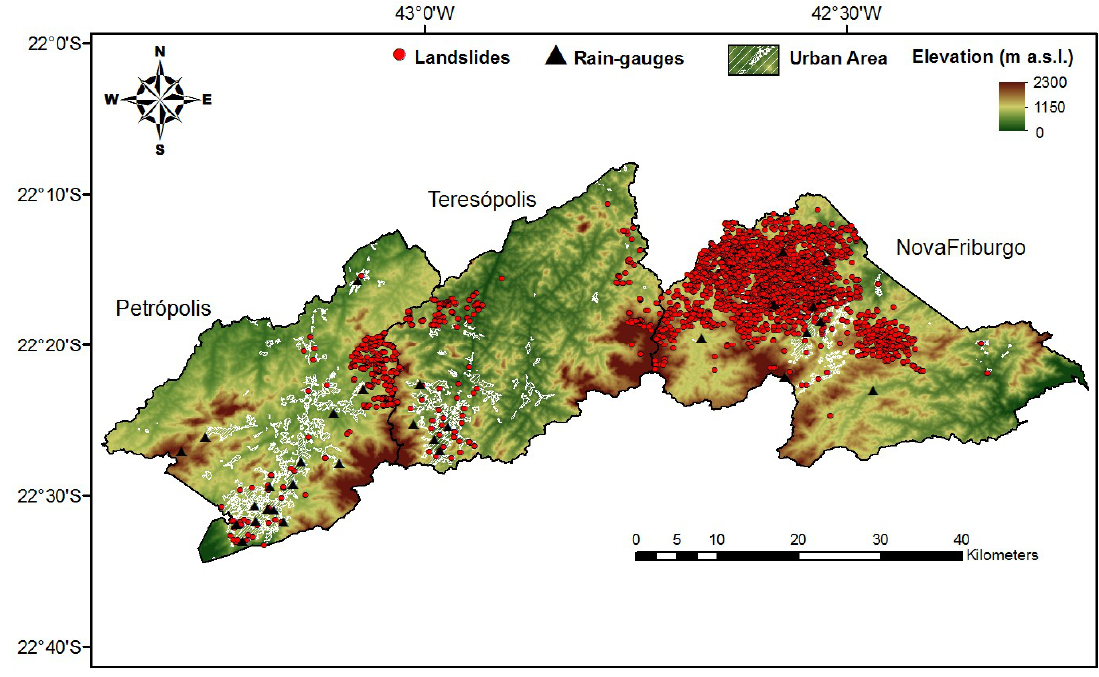
Figure 4. Landslide distribution and rain gauge positions in the study area.